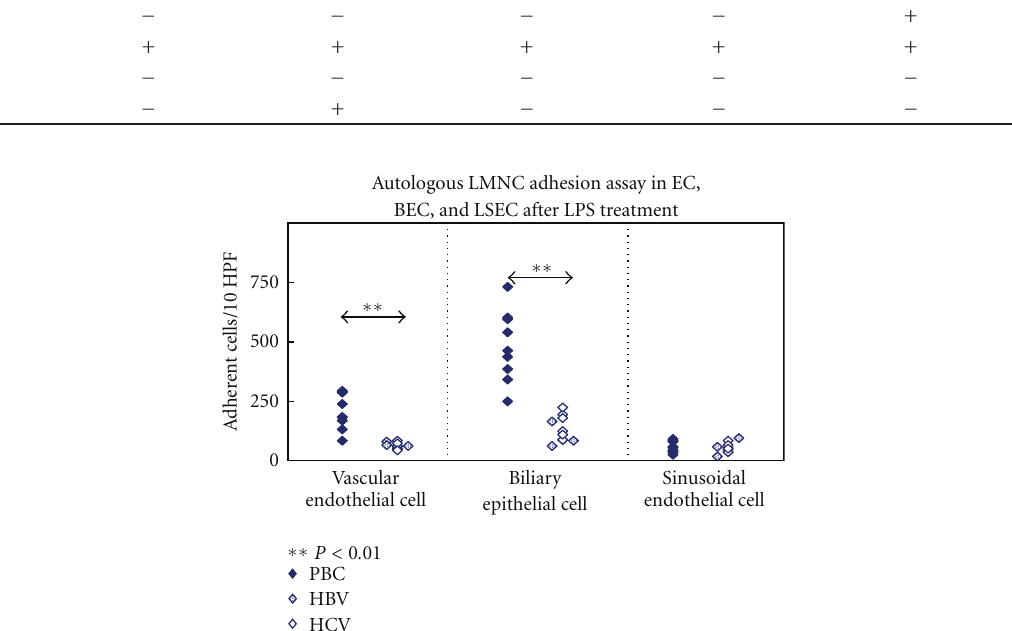
Figure 3: Autologous liver mononuclear cells adhesion assay using endothelial cells and BEC after stimulation with TLR4 ligand (LPS). Adherent liver mononuclear cells were stained and counted in ten random high-power microscopy fields. Liver mononuclear cells from PBC livers adhered in greater numbers than did liver mononuclear cells from controls using either endothelial cells or biliary epithelial cells, whereas liver mononuclear cells adhered only minimally to liver sinusoidal endothelial cells in all instances. Other TLR ligands did not accelerate liver mononuclear cells adhesion with neither endothelial cells nor biliary epithelial cells (data not shown).